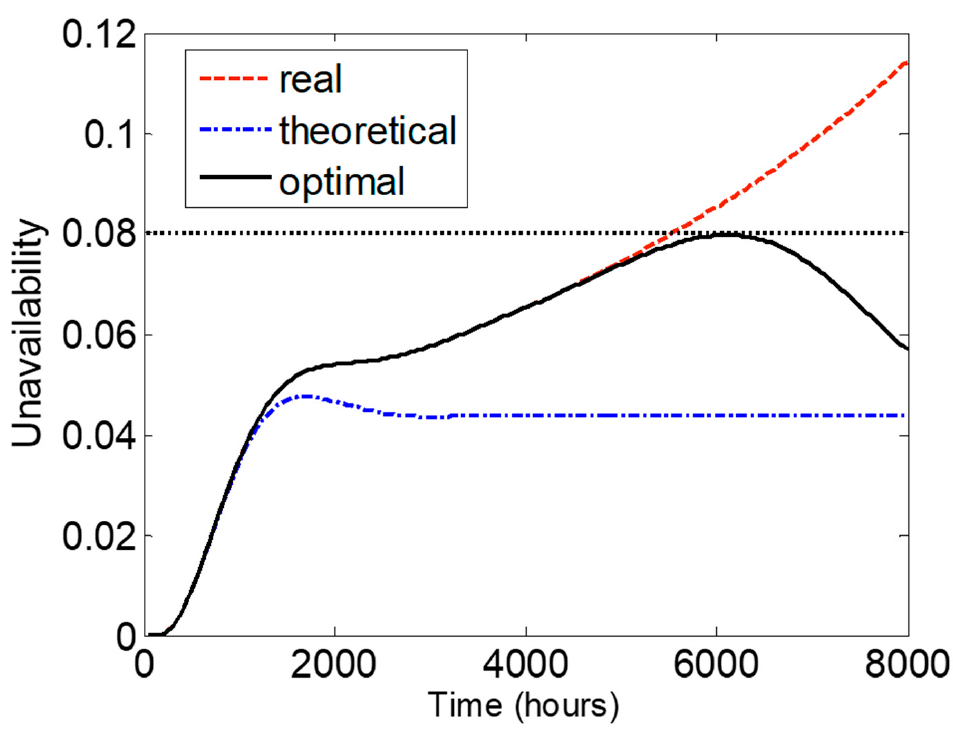
Figure 8. The unavailability function of the optimal FBM in a four-component system, U 0 = 0.08. FBM replacements affect both unavailability and cost. We can further see in Table 3 that the cost of all configurations ranges from 125.2 to 140.6 cost units. Low unavailability values in the first section of Table 3 are caused by frequent FBM replacements—see the often-repeated index 1, which means a minimal value for the decision variable n =